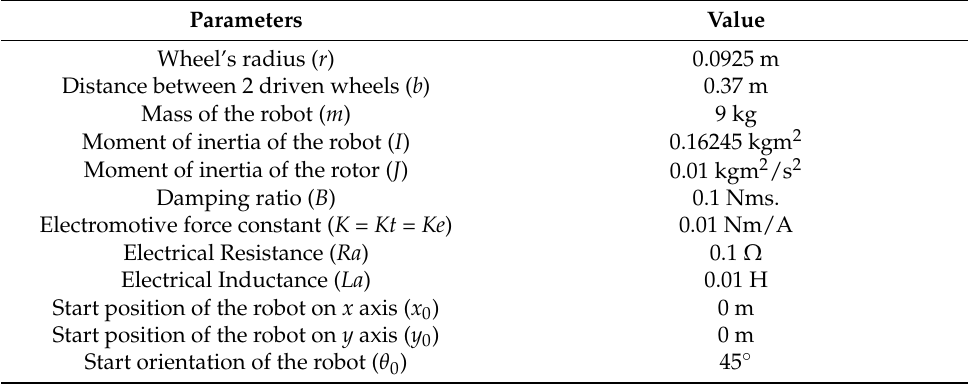
Table 5. Parameters of the differential drive wheeled mobile robot.